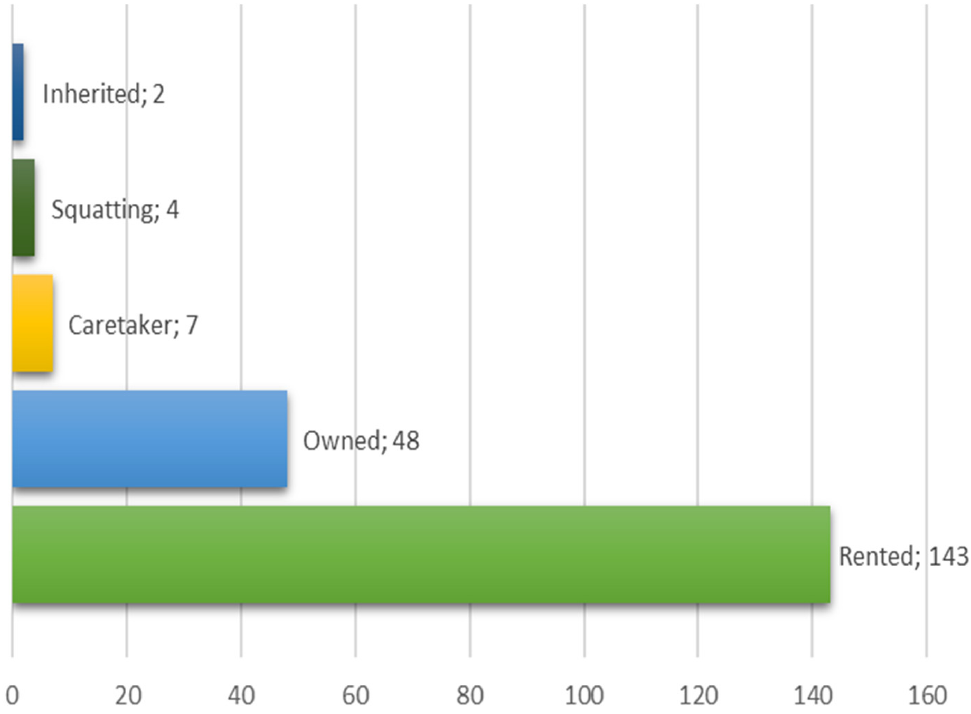
Figure 3. Occupancy status of respondents. Source: Fieldwork.